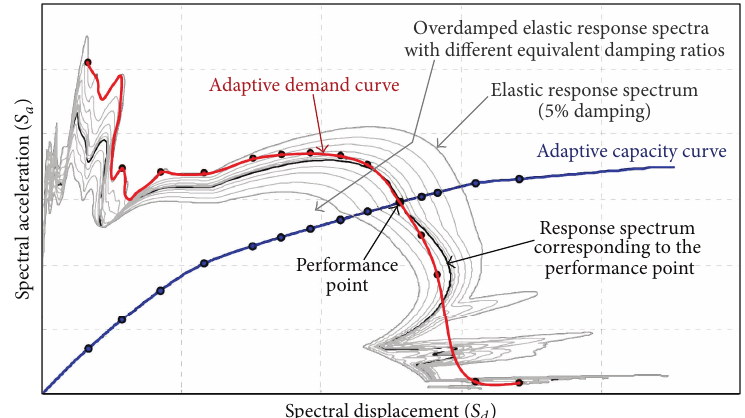
Figure 1: The proposed procedure for detection of the performance